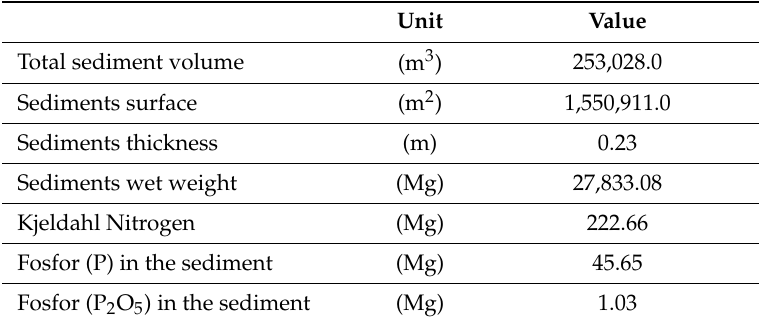
Table 8. Estimated amount of sediments and nutrients accumulated in them in the Paprocany reservoir (own